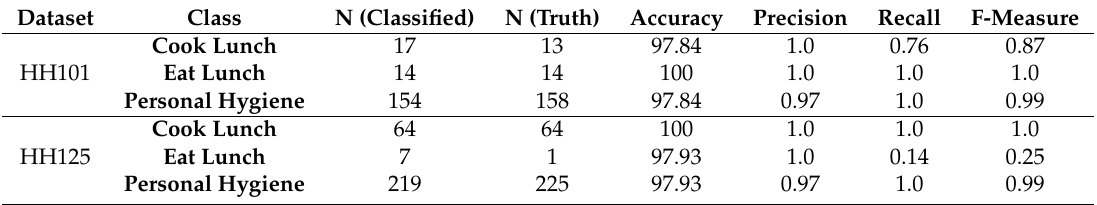
Table 9. Performance metrics for zero-shot activity recognition—Scenario